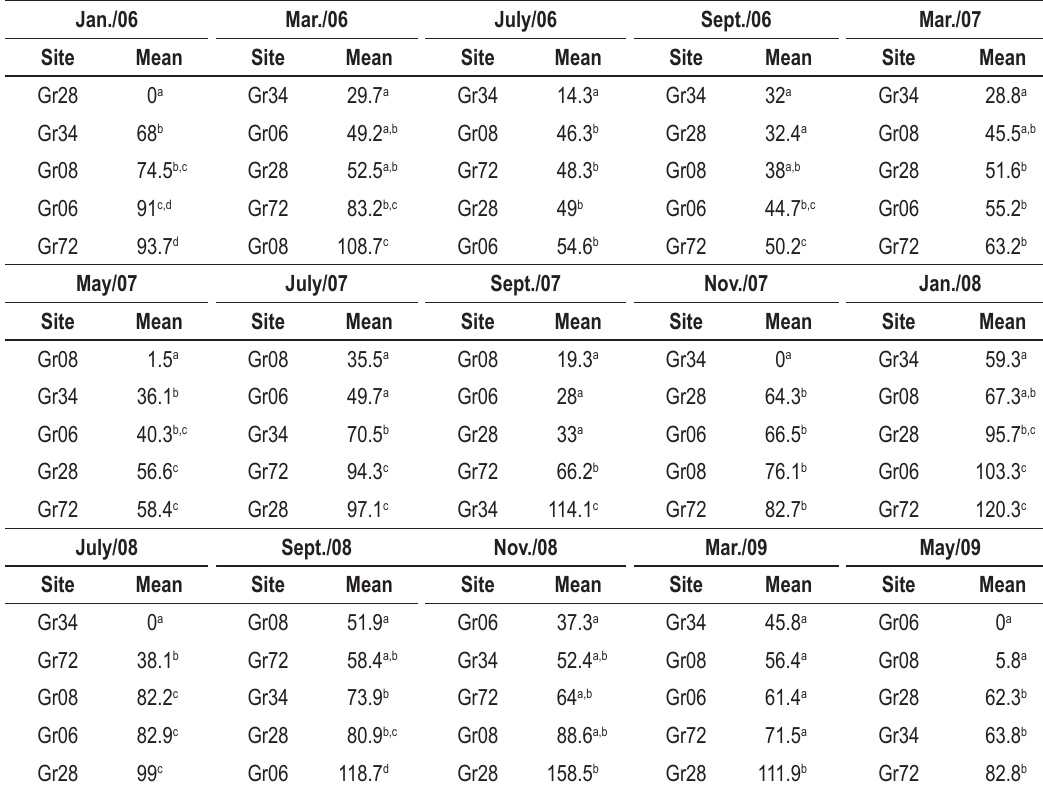
Table 1. Comparison of means between sites per month.